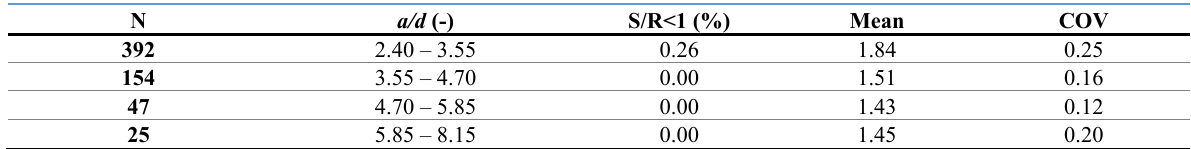
Table 9- S/R x a/d to the Unified